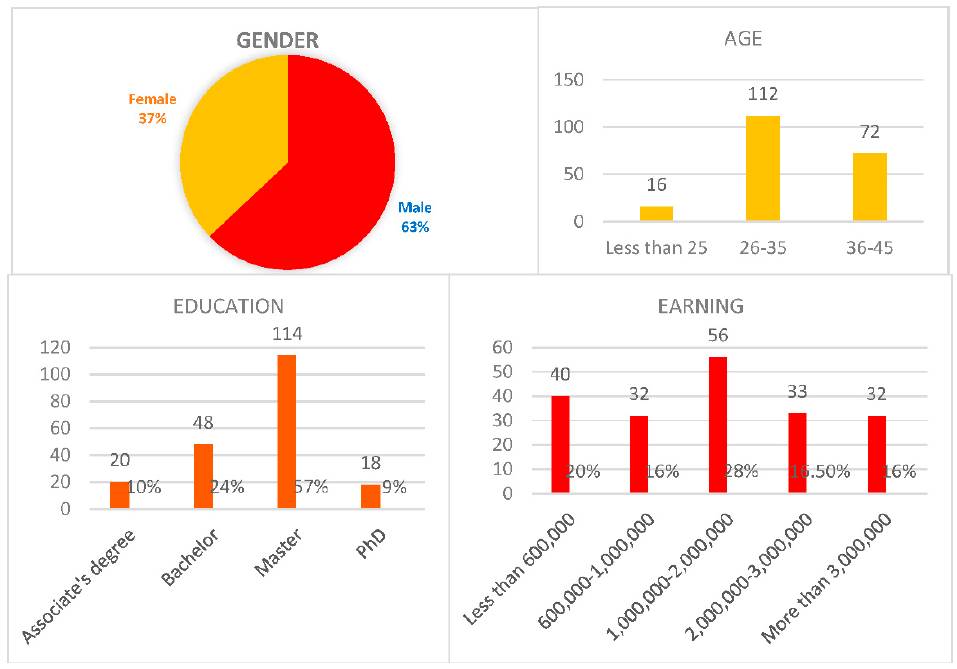
Figure 4. Gender, Age, Education, and Earning of a statistical sample.